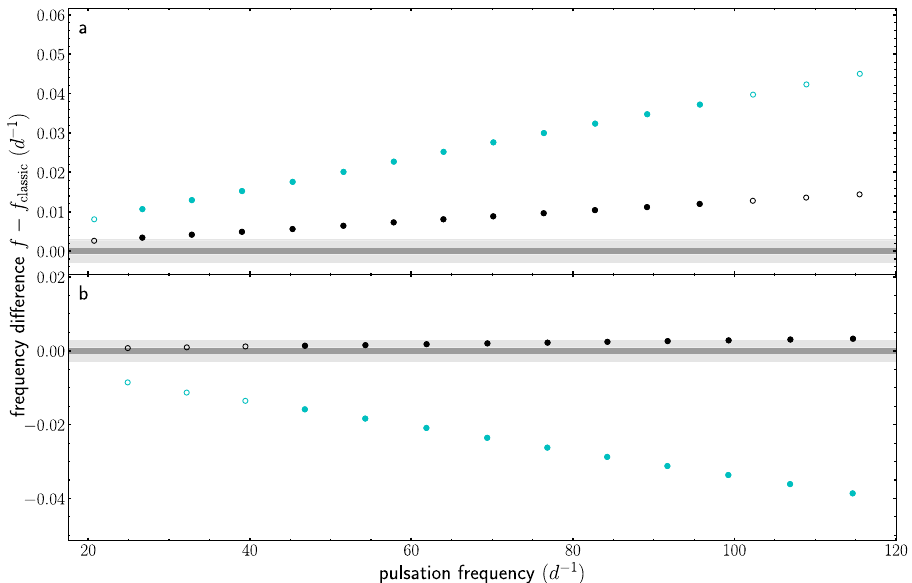
Fig.4|Resultingfrequencydifferencesfordifferentevolutionarycalculations. The frequency difference of l =1, m =1 modes as a function of the pulsation fre- quency. The black (turquoise) circles correspond to differences between the disk- mediated accretion (constant accretion) model and the classical model. Unstable modes are shown as fi lled circles, while stable modes are depicted as open circles.